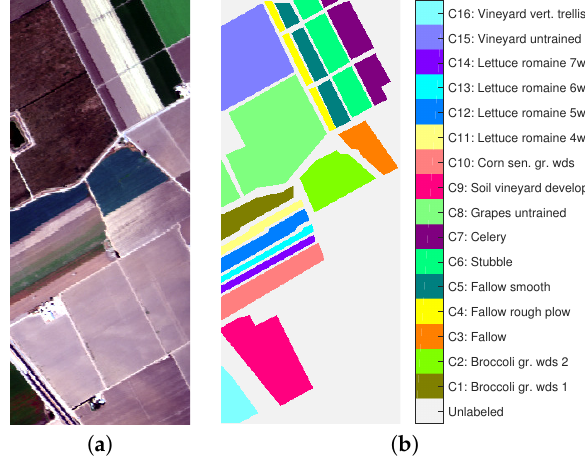
Figure 7. Salinas HSI. ( a ): color composite (bands 30, 20, 10); ( b ) ground truth